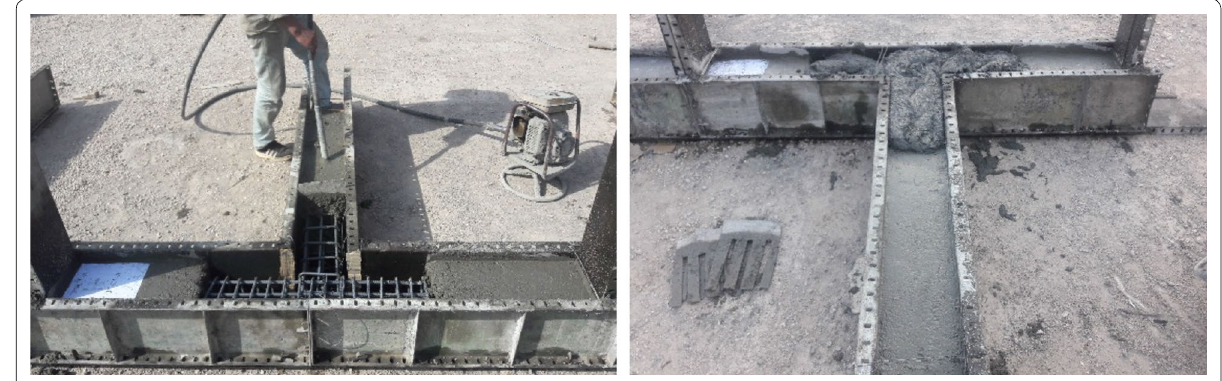
Fig. 11 Concreting pattern of HPFRCC.